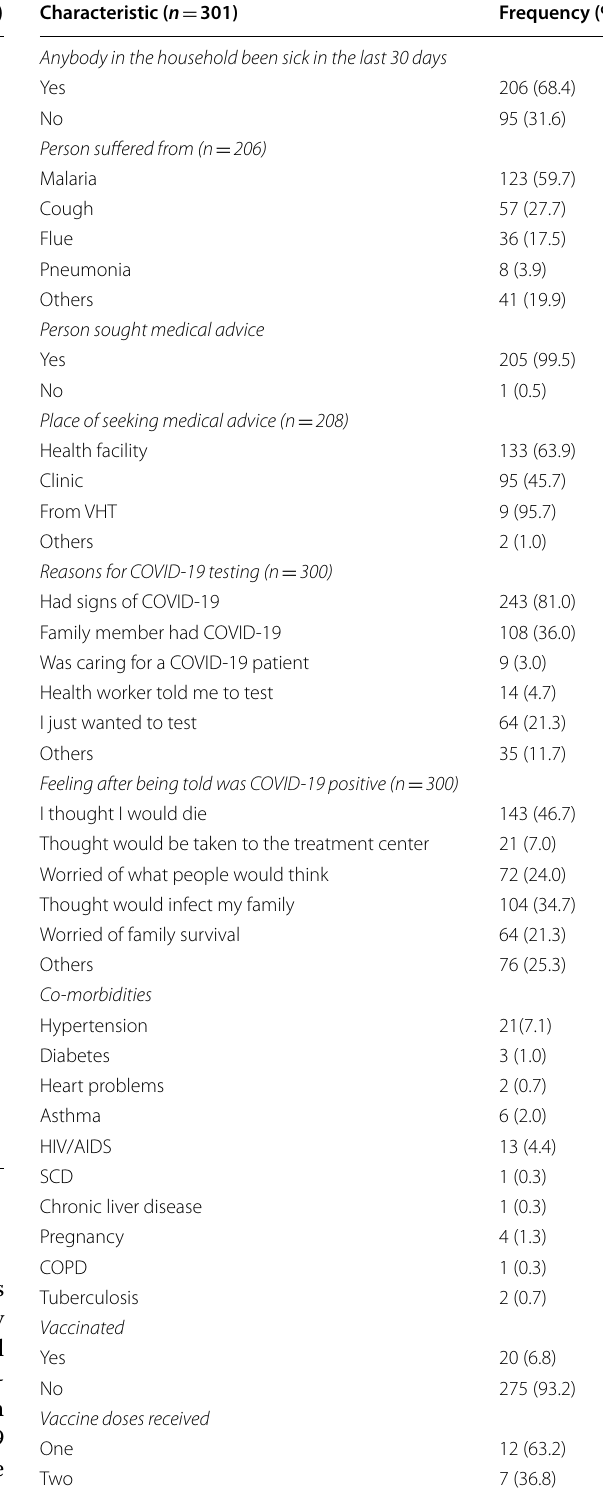
Table 2 Socio‑demographic characteristics of COVID‑19 Table 3 Clinical characteristics of COVID‑19 patients managed under home‑based care in Kapelebyong district in